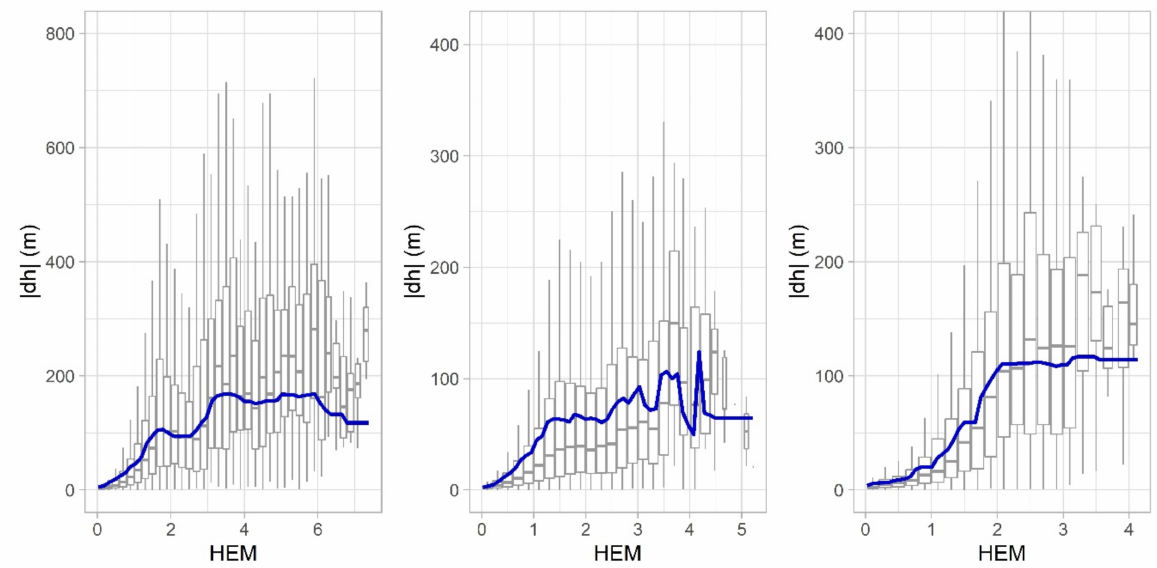
Figure 6. Partial dependency plots for boosted tree analyses of the absolute vertical error (i.e., the absolute value |dh| of the difference between the TanDEM-X DEM and the LiDAR DSM): the Alps (left), the Pyrenees (middle), the Tatra Mountains (right). The partial plots (in blue) show the modeled relationships between the absolute vertical error (|dh|) and the HEM values. The boxplots show the actual measured differences between the TanDEM-X DEM and the LiDAR DSM. Box limits indicate the range of the central 50% of the data, with the central line in the box marking the median